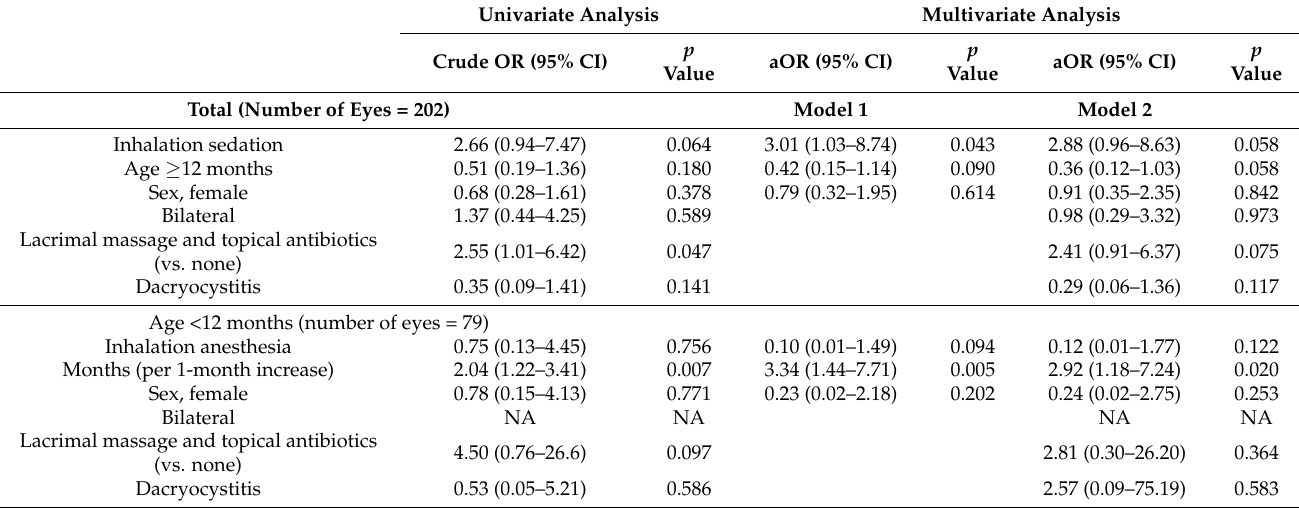
Table 3. Logistic regression analysis evaluating the factors associated with success of